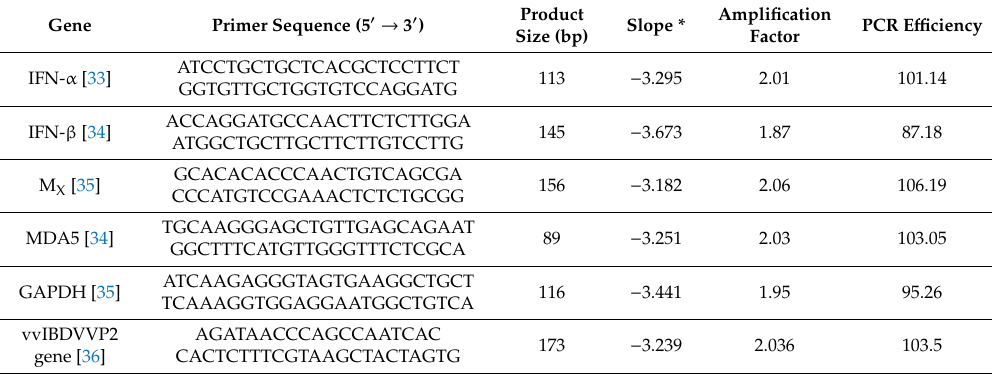
Table 1. Details of primer sequences used for Quantitative Real-Time